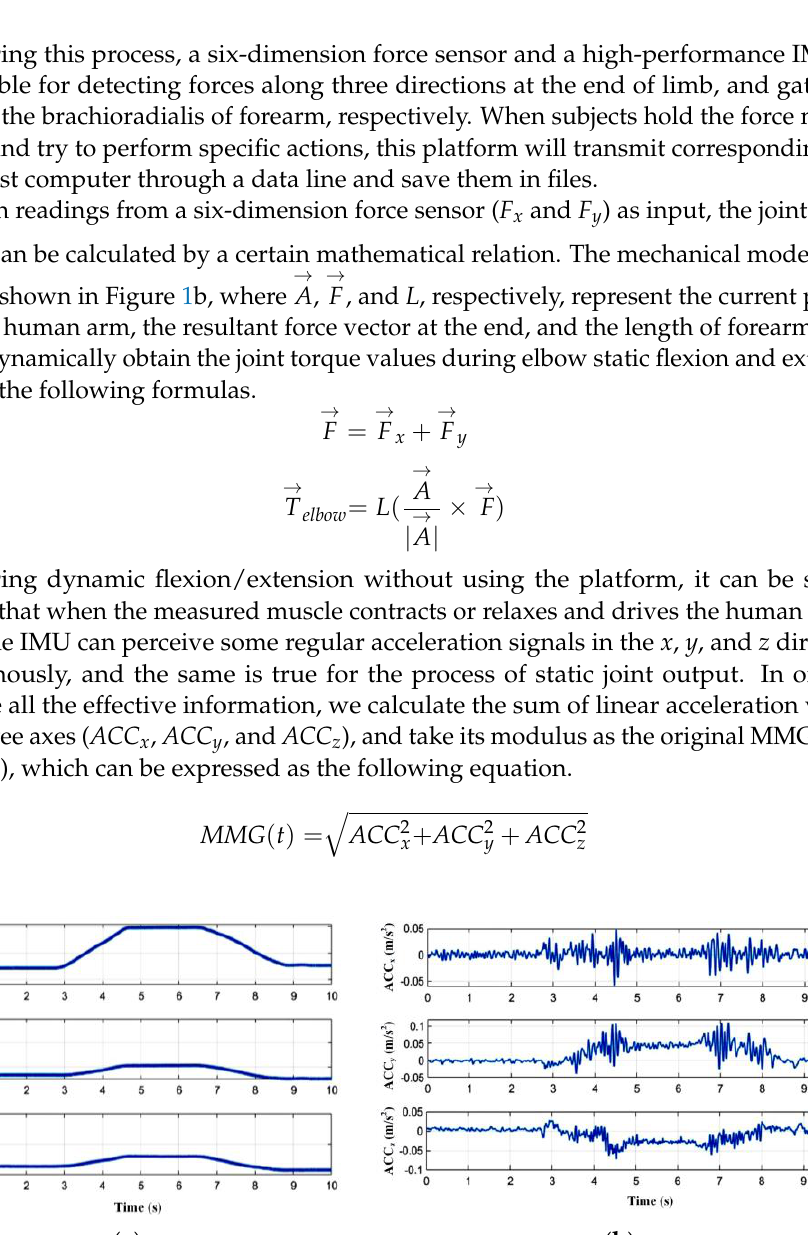
Figure 1. Information collection process during elbow static flexion/extension: ( a ) measurement platform; ( b ) joint torque calculation model for elbow.